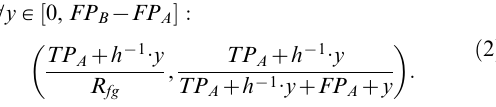
real label fg bg